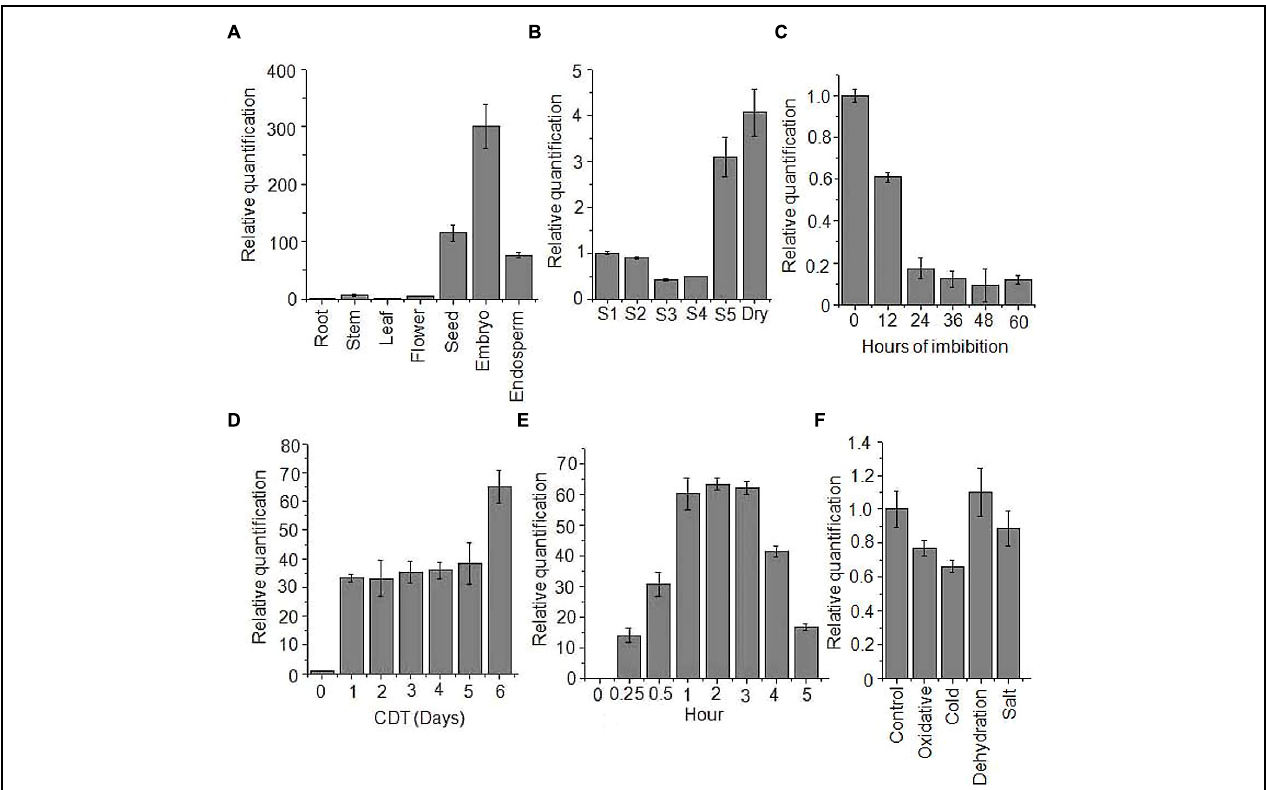
FIGURE 2 | Expression profiling of OsHSP18.2 . Transcript accumulation was analyzed by quantitative real time PCR (A) in different organs, (B) during seed development, (C) during seed germination, (D) under CDT, (E) under heat stress, and (F) under various abiotic stresses. Actin was used as an endogenous control. The relative expression value of each gene was normalized to an endogenous control and calculated using the (cid:2)(cid:2) CT method (Applied Biosystems). Expression values are the mean ± SD of three independent biological